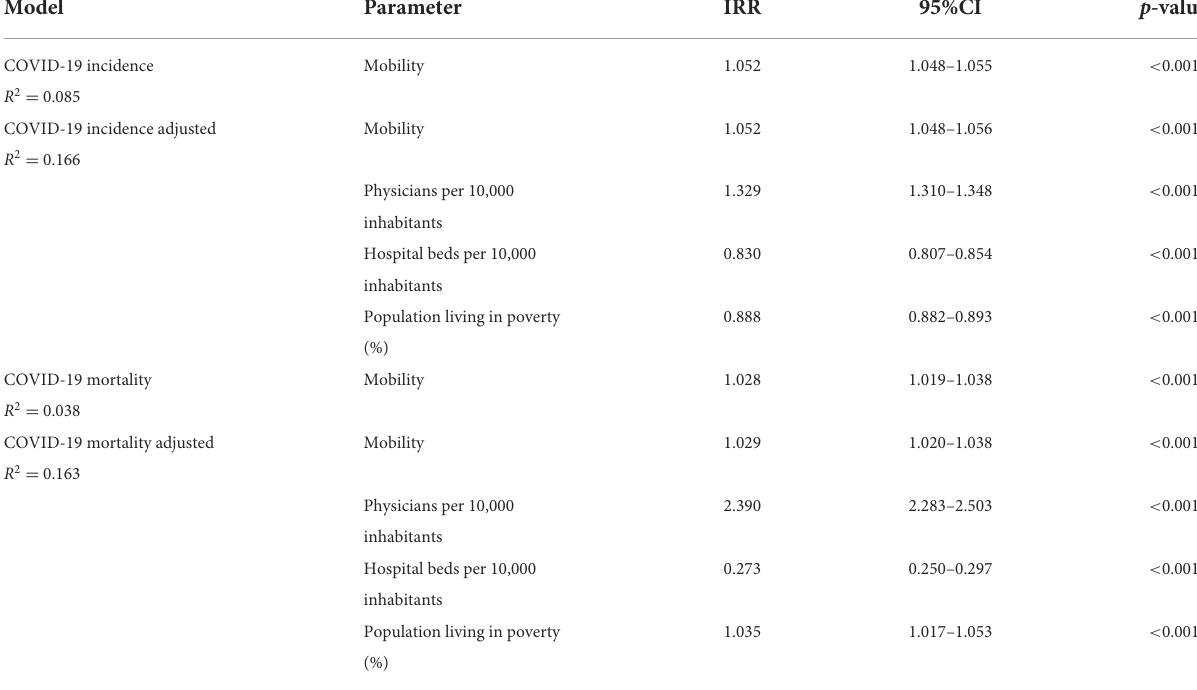
TABLE 3 Results from mixed-effects Poisson regression models to evaluate the influence of mobility on the incidence of positive COVID-19 cases and COVID-19 mortality rates in all states being assessed. Model